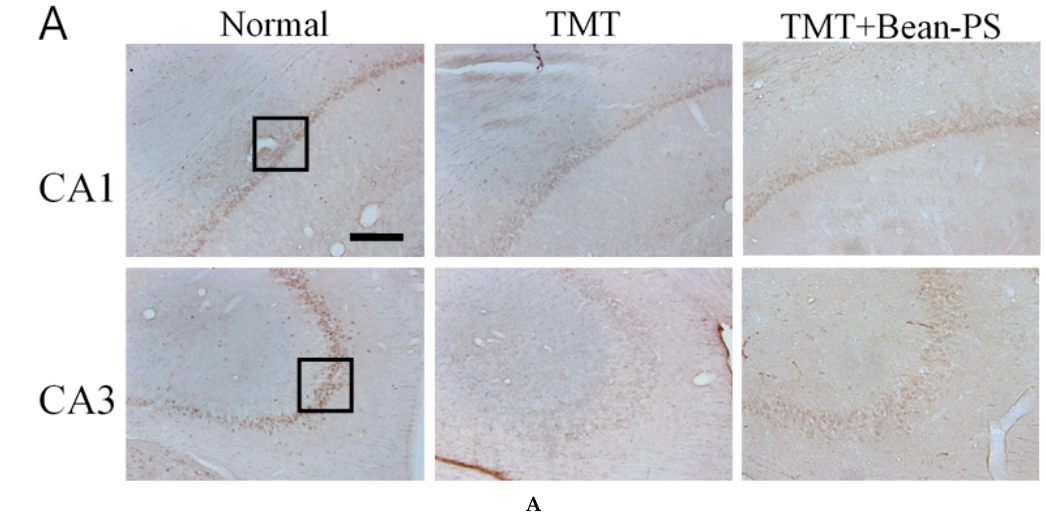
A Figure 3. Cont